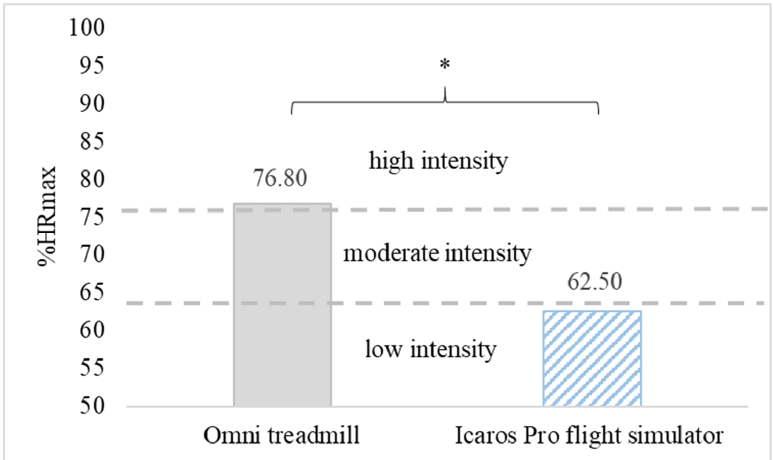
Figure 3. The average intensity of physical e ff ort during active video games (AVGs) in VR on the Omni treadmill and Icaros Pro flight simulator, * p <